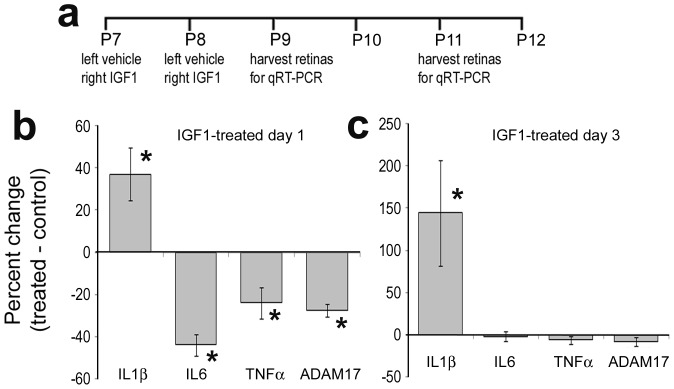
Levels of pro-inflammatory cytokines fluctuate in retinas treated with IGF1.qRT-PCR was used to measure levels of mRNA in retinas treated with IGF1 at 1 and 3 days after treatment. qRT-PCR was used to measure retinal levels of IL1β, IL6, TNFα and ADAM17. Significance (*p<0.01) of difference between mRNA levels in control and IGF1-treated retinas was determined by using a two-tailed Student’s t-test.